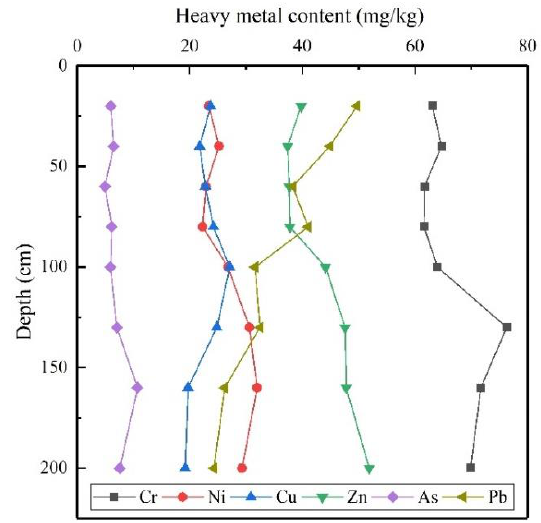
Figure 2. Contents of heavy metals (HMs) in soil profiles.